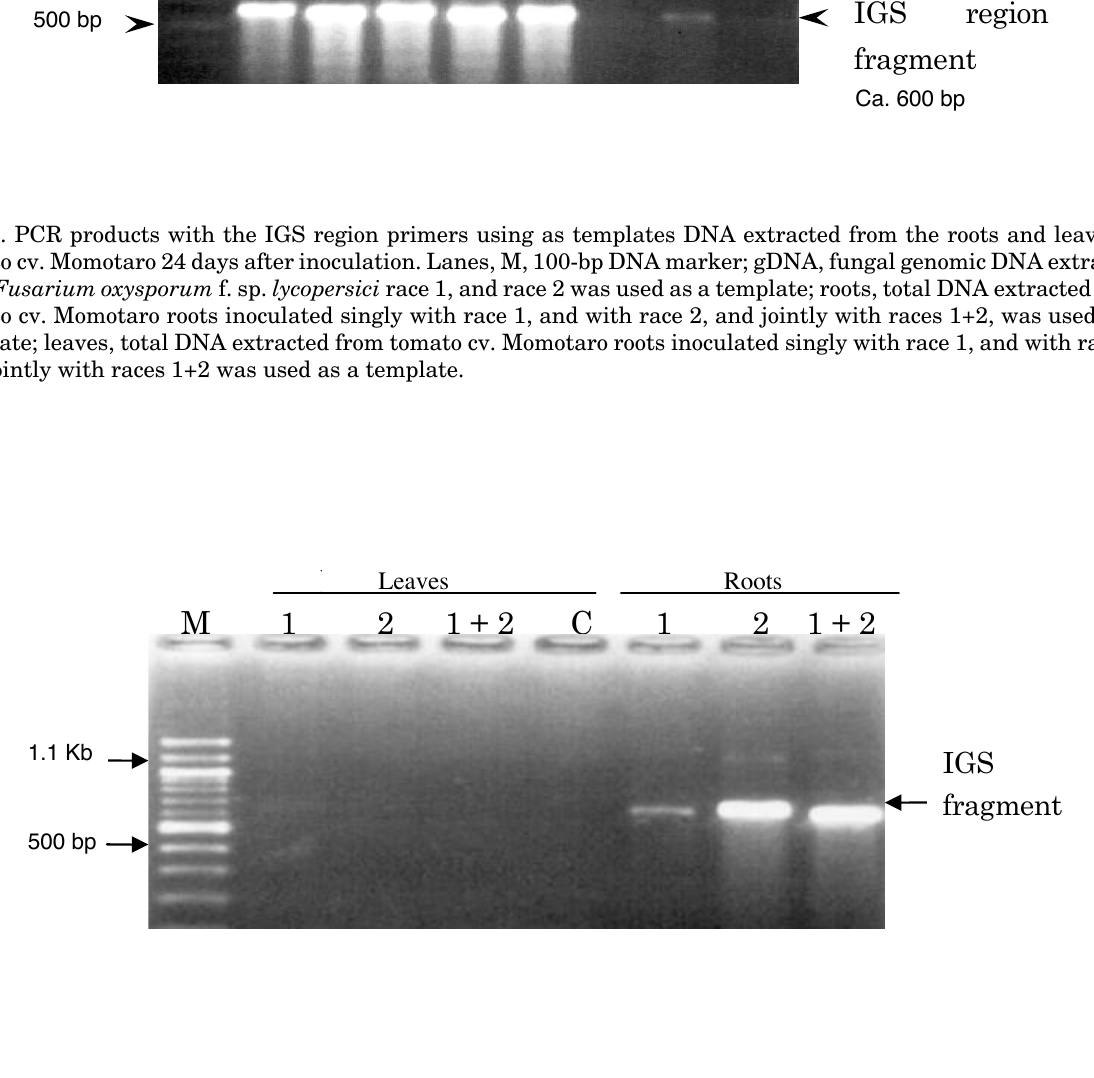
Fig. 6. PCR products with the IGS region primers using as templates DNA extracted from the roots and leaves of tomato cv. Ponderosa 24 days after inoculation. Lanes: M, 100-bp DNA marker; leaves, total DNA extracted from tomato cv. Ponderosa roots inoculated singly with race 1, and with race 2, and jointly with races 1+2 was used as a template; roots, total DNA extracted from tomato cv. Ponderosa roots inoculated with water (C), and singly with race 1, and with race 2, and jointly with races 1+2 was used as a template.